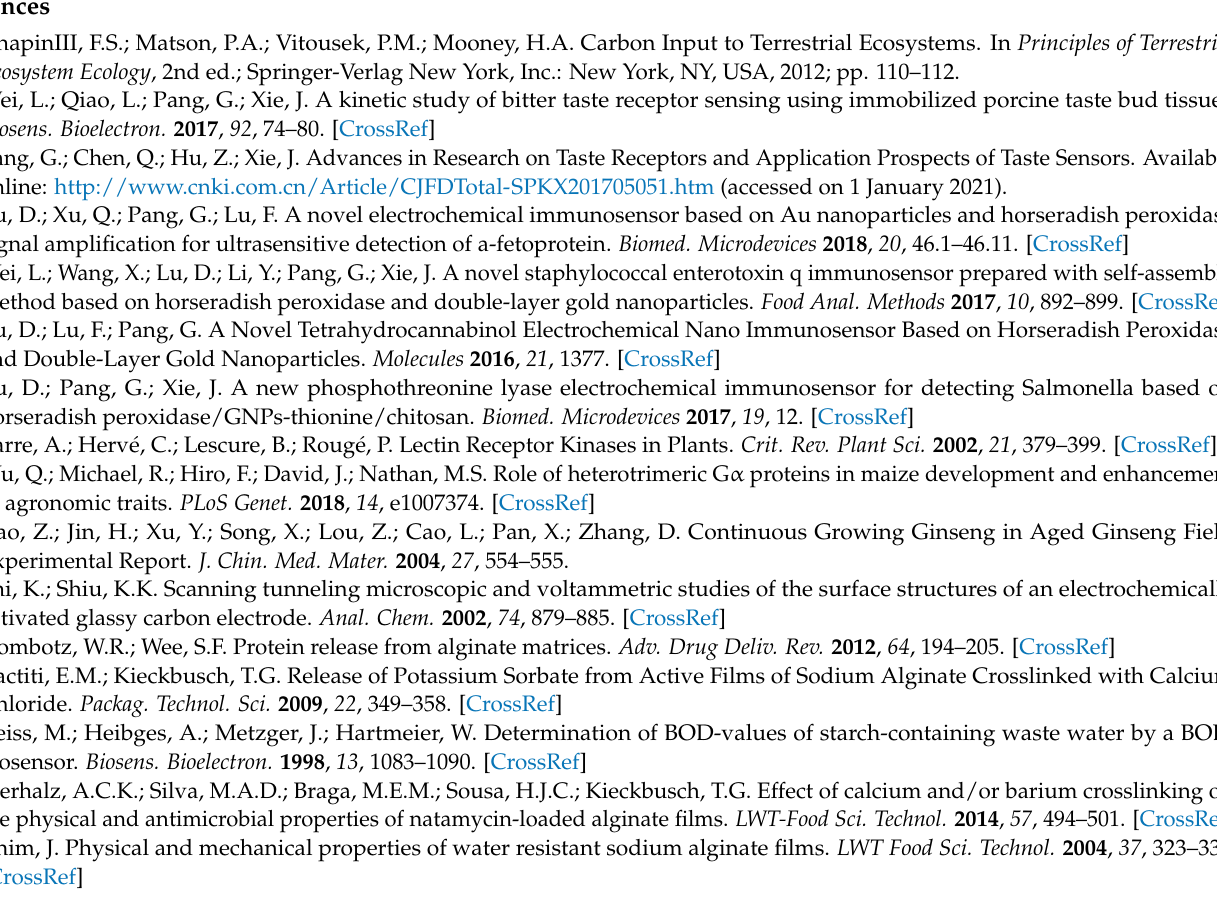
bare electrode, Figure S2: Cyclic voltammograms of the bare electrode at different scan rates, Figure S3: Optimization of detection potential, Figure S4: Rate of current-change of five nitrogen nutrients in the detection concentration range of two-, four-, and six-year-old ginseng root-meristem sensors, Figure S5: Response curve fitting of two-, four-, and six-year-old ginseng root-meristem sensors to five nitrogen nutrients in the concentration range, Figure S6: Double reciprocal pseudo-curve of five nitrogen nutrients in the concentration range of two-, four-, and six-year-old ginseng root-meristem